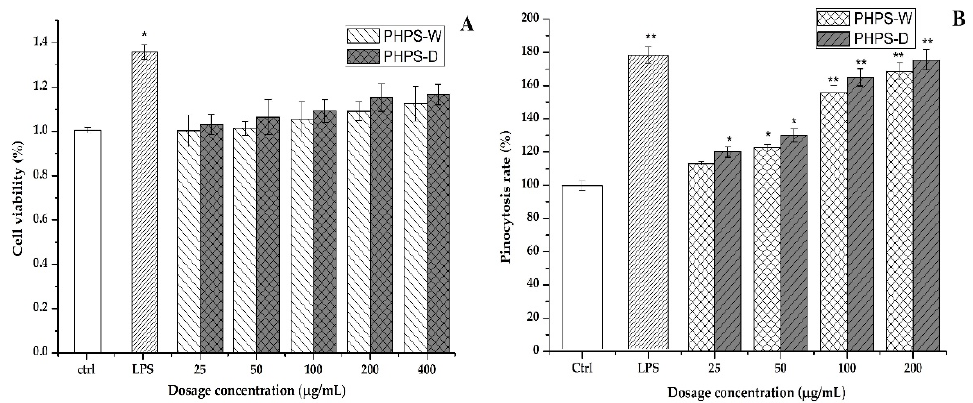
Figure 9. Effects of PHPS-D and PHPS-W treatments on RAW264.7 cells: cell viability ( A ), and pinocytosis rate of neutral red ( B ). Note: Each experiment was tested in triplicate, and the error bars are standard deviations, Significant differences in cell viability and pinocytosis rates of the samples vs. the control group are presented by * p < 0.05 and ** p < 0.01.